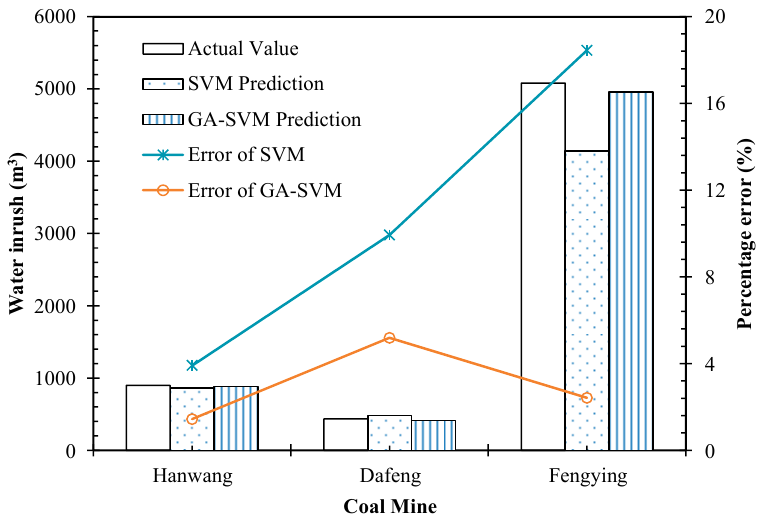
Figure 7. Predictive performance comparisons of the SVM and GA-SVM.